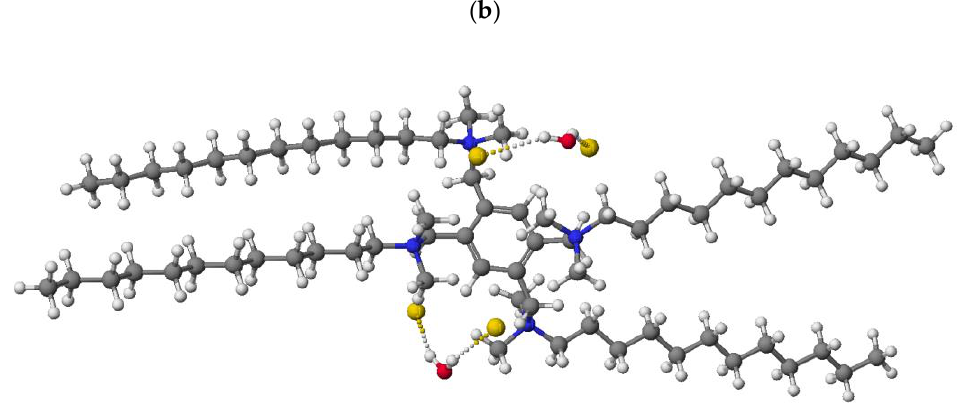
Figure 7. Comparison of the X-ray ( a ) and PM5 ( b ) structures of compound 21 .